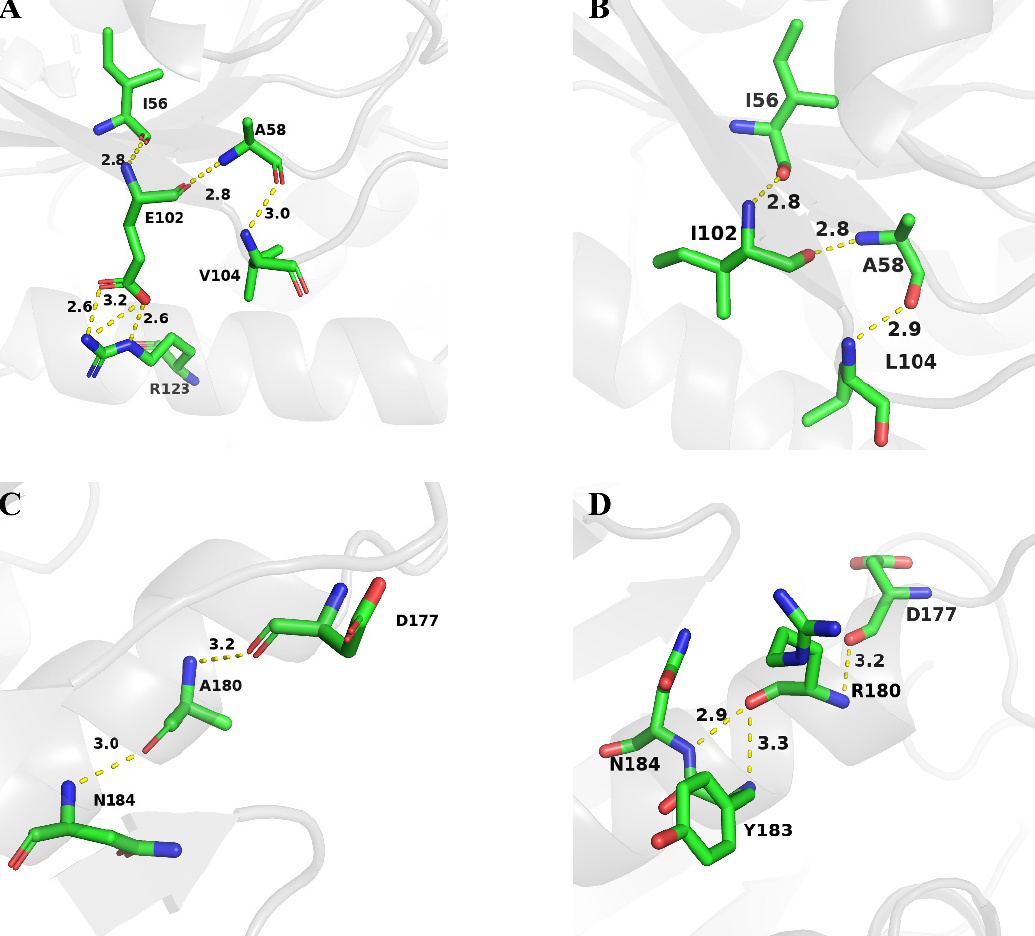
Figure 8. ( A , B ) Change in the residue interactions around the 102nd and 104th residue. ( C , D ) Change